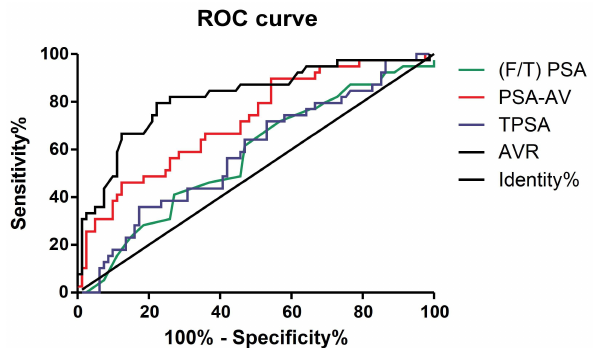
Fig. 1. ROC curves for PV, PSAD and AVR in the diagnosis of prostate cancer . ROC, Receiver operating characteristic; PV, Prostate volume; PSAD, Prostate-specific antigen density; AVR, Ratio of age to volume.